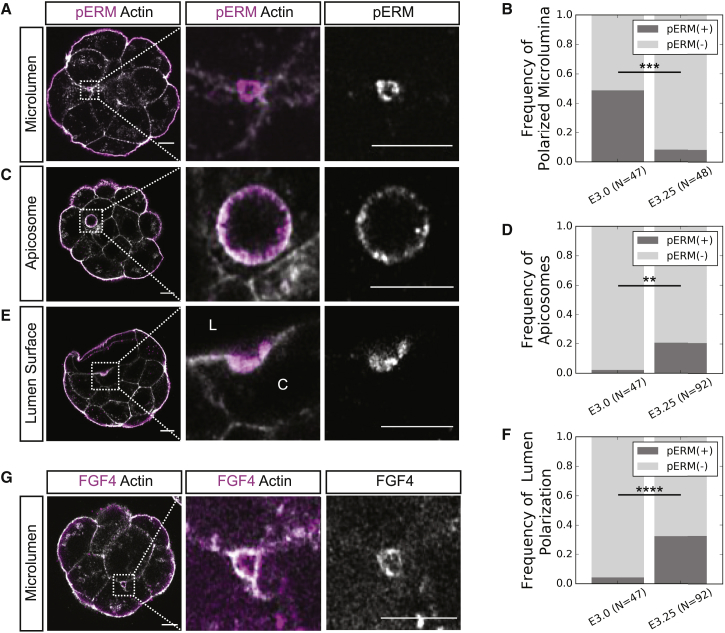
Microlumina Containing Secreted Apical Domain Components Are Transiently Upregulated during Early Phases of Fluid Accumulation(A) Representative immunofluorescence images of an apically polarized microlumina in an E3.0 embryo.(B) Frequency of apically polarized microlumina in E3.0 and E3.25 embryos (p < 0.001).(C) Representative immunofluorescence image of an E3.25 ICM cell containing an apicosome.(D) Frequency of apicosome occurrence in E3.0 and E3.25 embryos (p < 0.002).(E) Representative immunofluorescence image of an E3.25 ICM cell in which a subsection of its membrane facing the growing lumen is apically polarized (L-lumen; C-cytoplasm).(F) Frequency of lumen polarization in E3.0 and E3.25 embryos (p < 0.0001).(G) Z slice of an RNA-injected E3.0 embryo showing localization of FGF4-mNeonGreen to the membrane domains of a microlumen, representative of N = 7 embryos.All scale bars, 10 μm. Two-tailed Fisher's exact test ∗∗∗∗p < 0.0001, ∗∗∗p < 0.001, ∗∗p < 0.01See also Figures S2 and S3; Videos S5 and S6; Table S2.